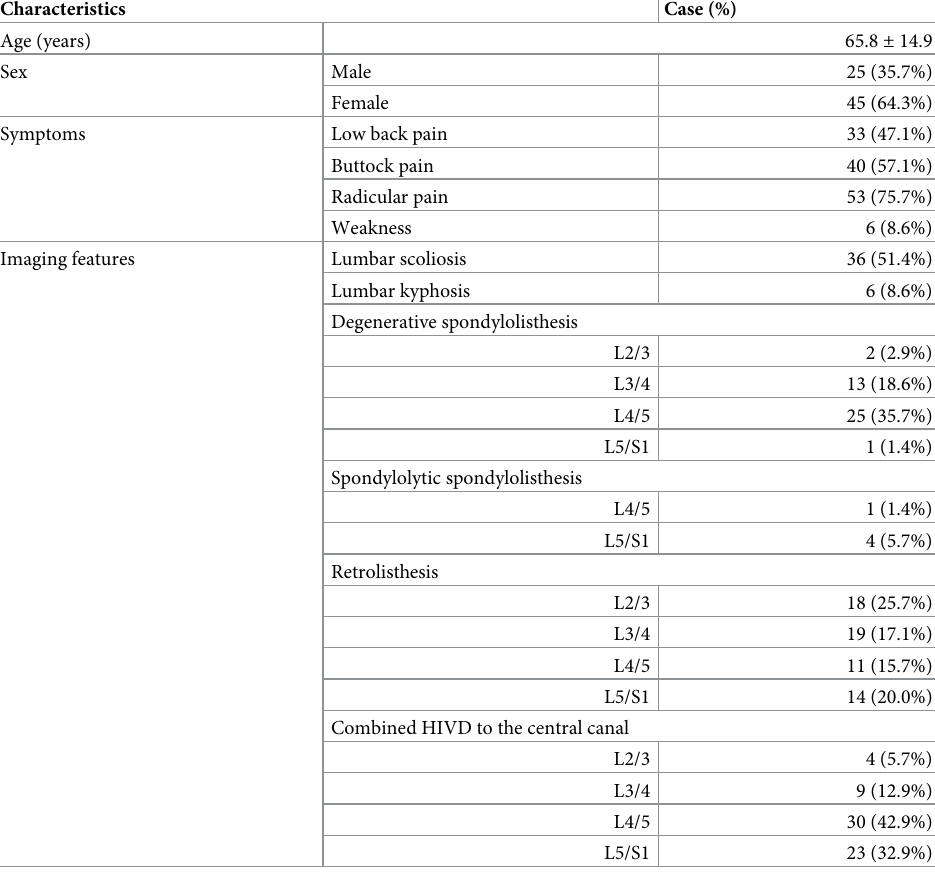
Table 1. Patient characteristics (n =